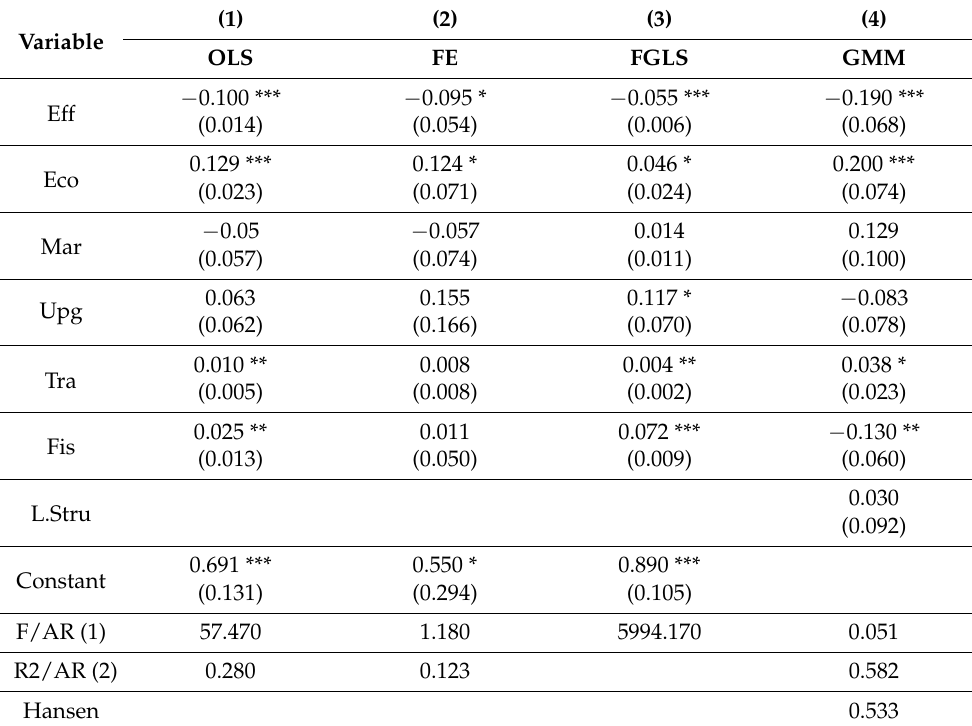
Table 2. Influencing factors of fishery industrial structure